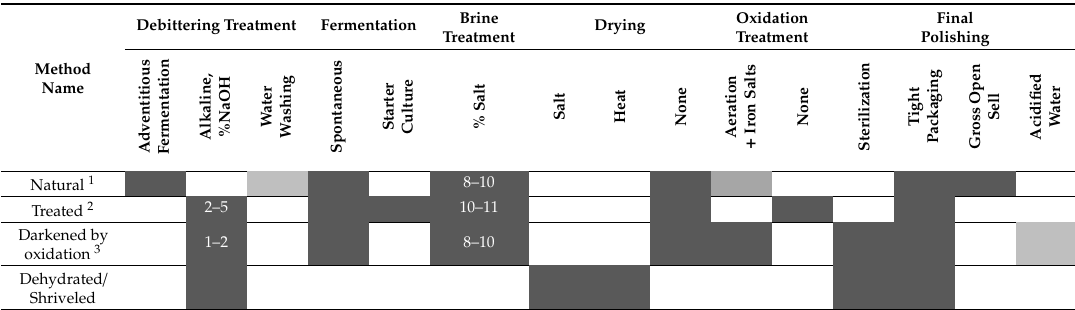
Table 1. Trade preparations of table olives. Dark grey indicates a required processing step, light grey indicates an optional step, and white indicates absence of such a